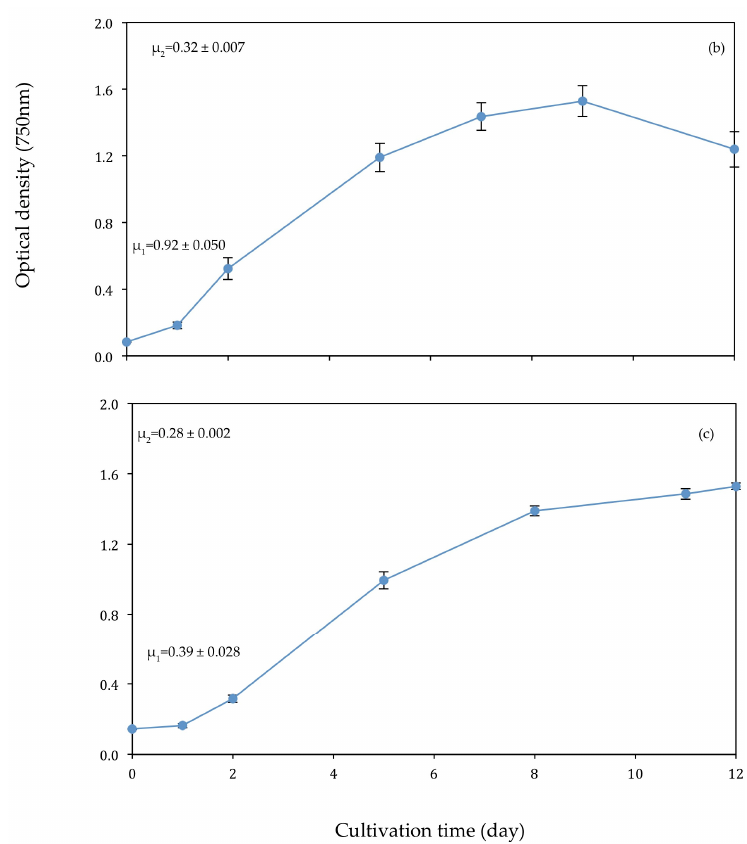
Figure 4. ( a ) Control ( b ) T1 ( c ) T2. Growth curves for C. vulgaris . Bars represent standard deviation (SD). Absence of a bar indicates negligible SD. μ 1 = initial growth rate ± 1 SD, μ 2 = overall growth rate ± 1 SD. Statistical analysis of the difference in specific growth rates across conditions could not be conducted; however, values for optical density differ significantly between conditions when analysed by nested ANOVA ( f = 30.515, p = 0.005), suggesting a significant difference in growth across conditions.